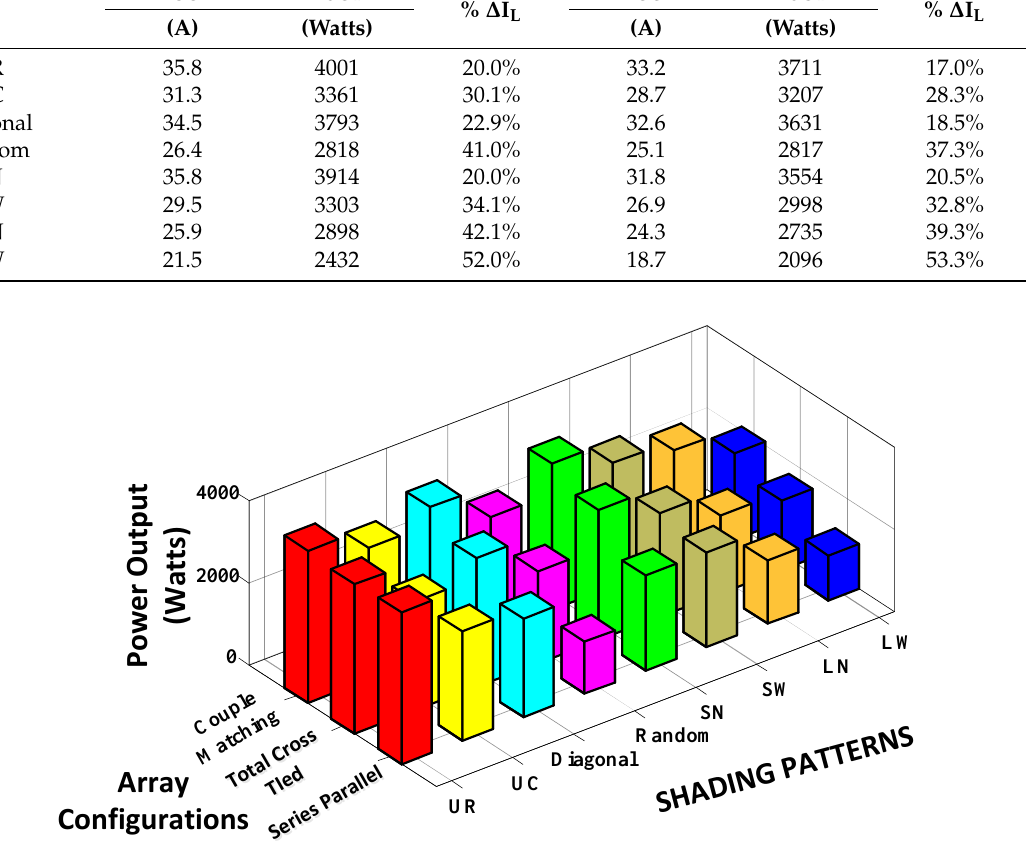
Figure 10. Comparison chart of output power.